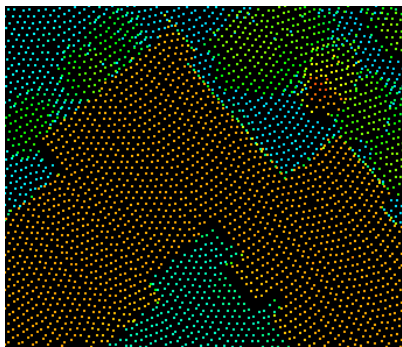
Figure 3. A sample of Optech ALTM 3100 ALS data with a point density of 2-3 points/m 2